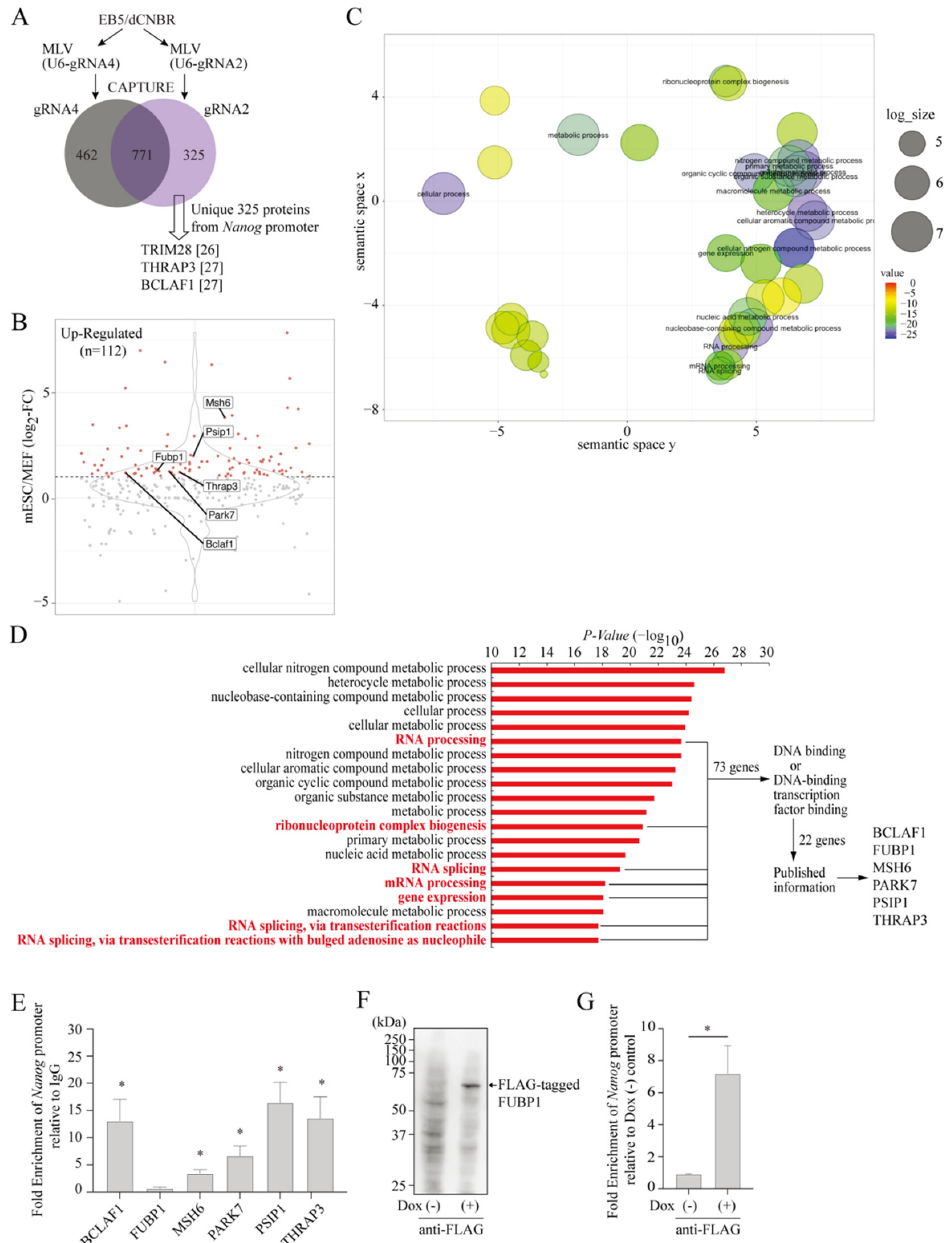
Figure 2. Purification of proteins binding to the Nanog promoter in mESCs. ( A ) Venn diagram of identified proteins by LC/MS/MS using gRNA2 and gRNA4. Proteins were identified from three independent experiments. In total, 325 proteins were obtained as unique proteins for